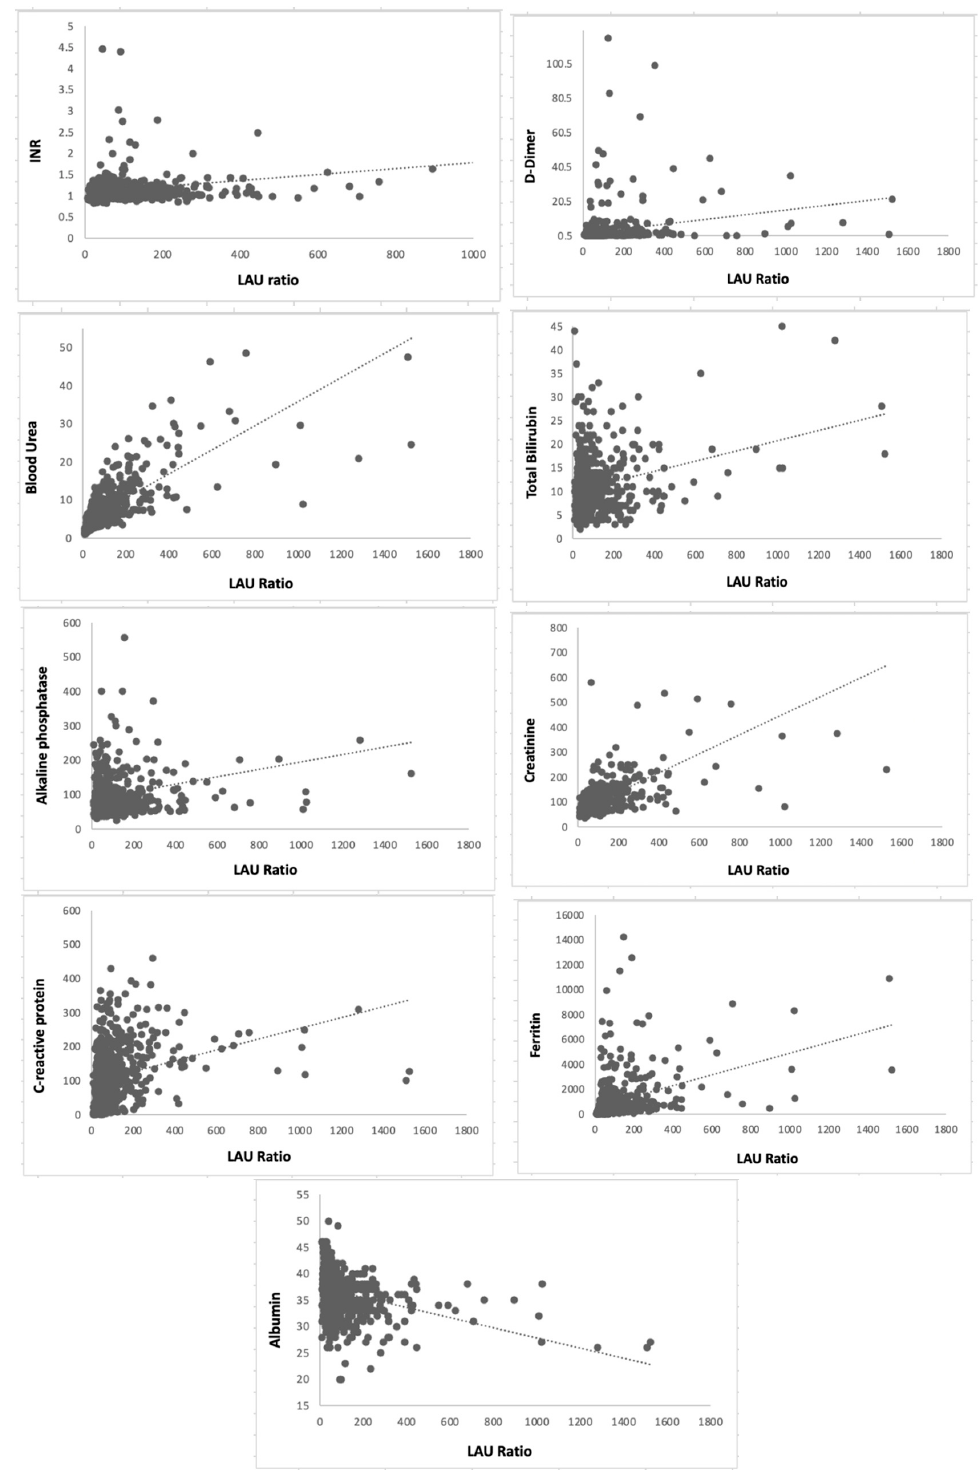
Figure 2. Correlation studies between Lactate dehydrogenase/Albumin to-urea ratio (LAU) and Infection-related clinical complications prognostic parameters.